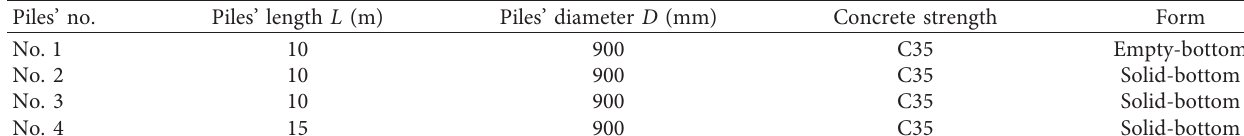
Table 4: The characteristic parameters of each tested pile.